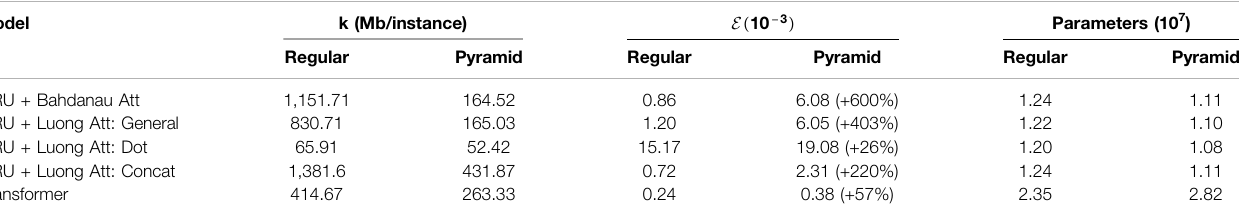
TABLE 4 | Memory cost for considered models, comparing regular encoder and pyramid encoder: pyramid encoder greatly increased the memory ef fi ciency.